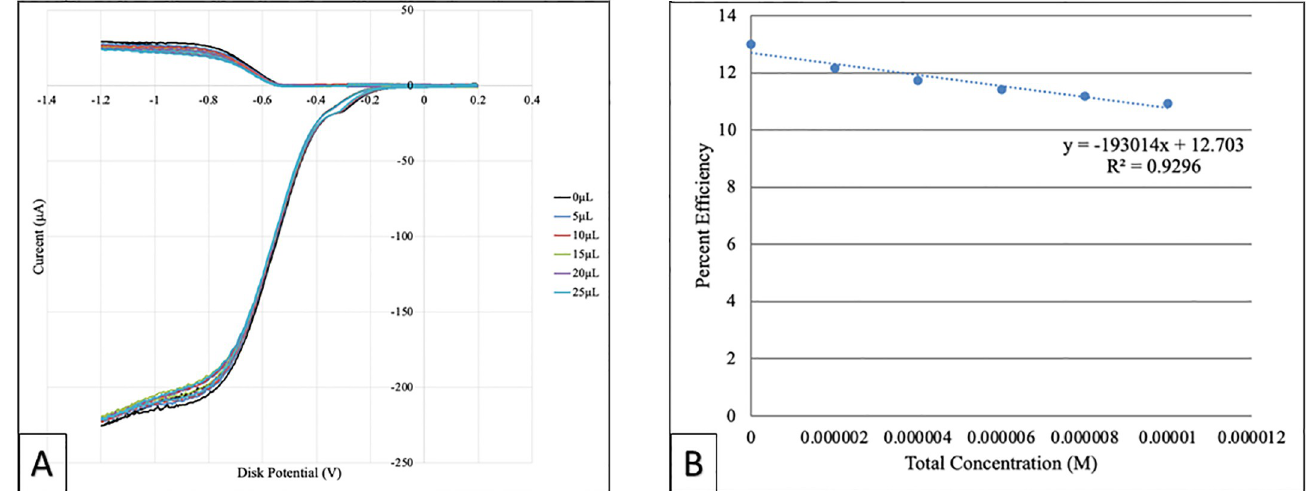
Fig 10. A: A total of 5 runs of galangin were performed in this study. This CV compilation shows the initial blank, black color, and colored aliquots added of galangin; B: Antioxidant Efficiency of galangin, as function of molarity.